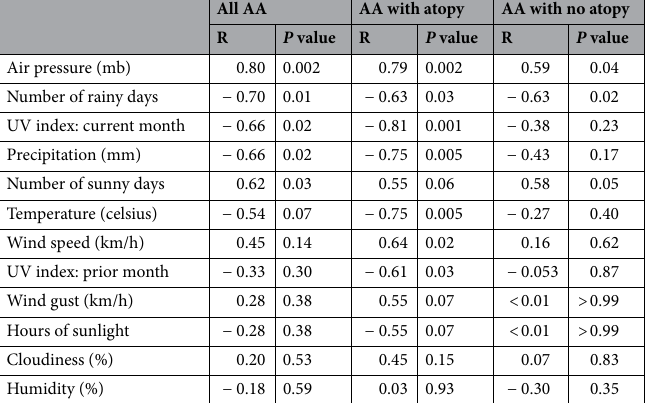
Table 1. Correlation coefficients (Rs) between the frequency of alopecia areata (AA) flares and meteorological variables per month in Philadelphia, Pennsylvania, for children with AA, for children with comorbid AA and atopic conditions, and for children with AA without atopic conditions. Number of flare episodes in atopic AA patients: 198. Number of flare episodes in non-atopic AA patients: 320.